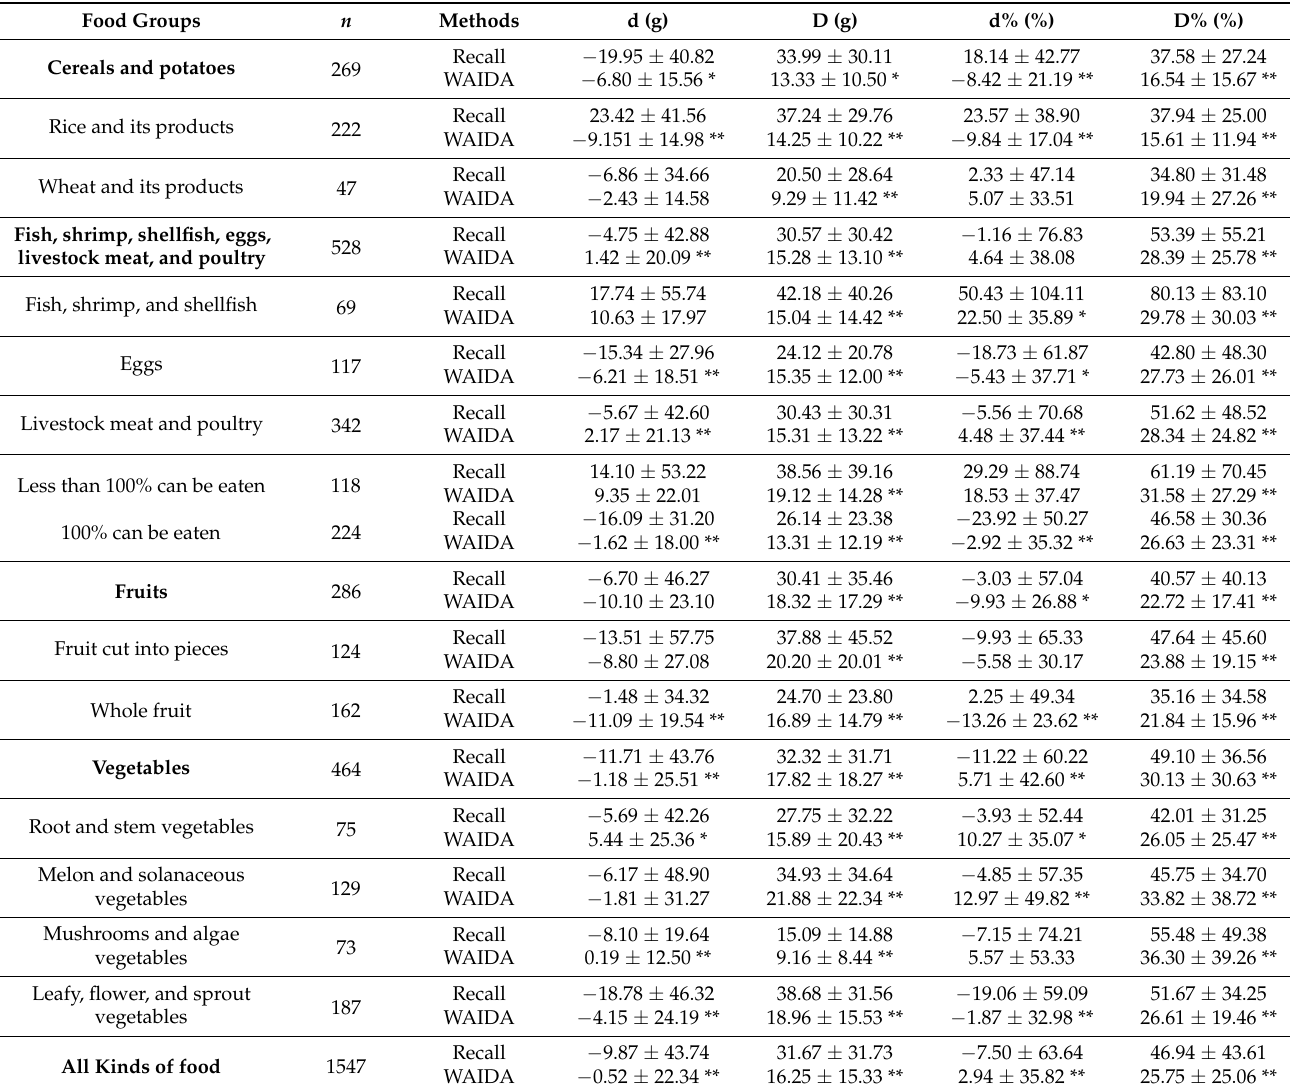
Table 1. Comparison of the food weight estimated by the recall or WAIDA method with the actual food weight (Mean ±